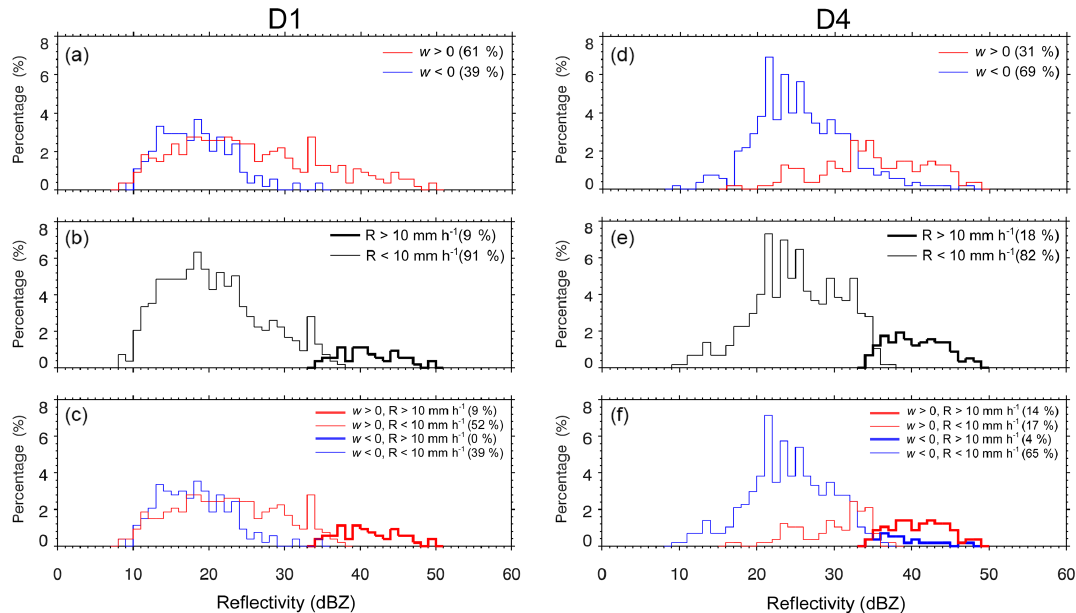
Figure 8. Frequency histograms of Z with regard to w , R , and these in the four groups with percentages at D1 and D4.